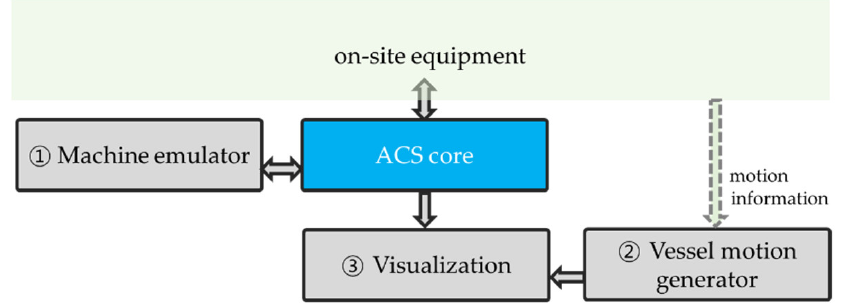
Figure 1. Overall structure of display and data flow between modules of the digital twin for an anti-collision system of an offshore drilling unit.